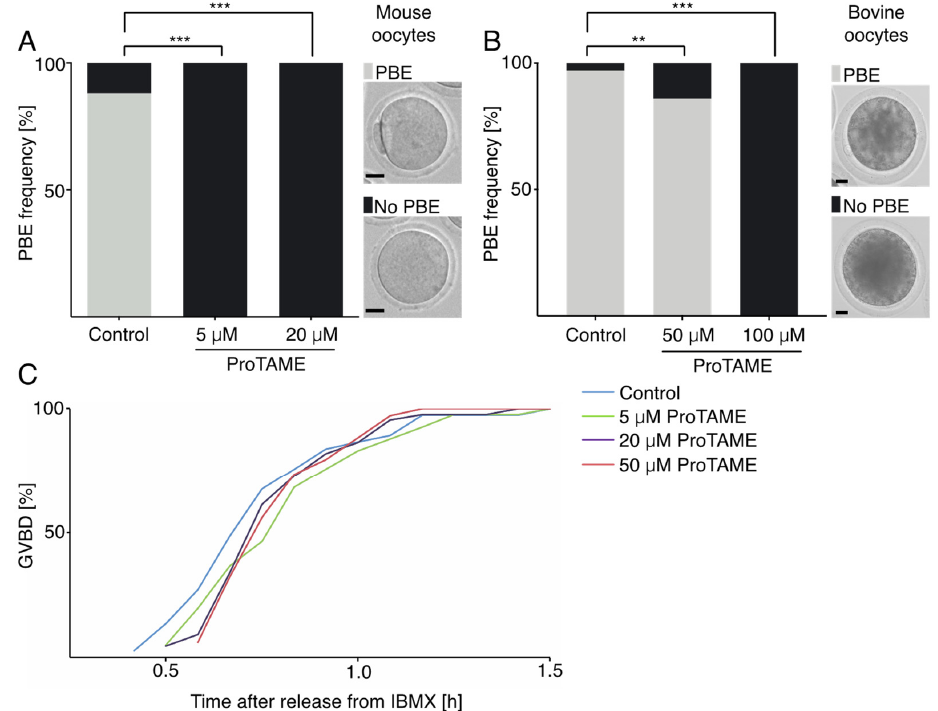
Figure 1. The impact of prodrug tosyl- l -arginine methyl ester (proTAME) on the meiotic maturation of mouse and bovine oocytes. ( A ) The frequency of polar body extrusion (PBE) in mouse untreated oocytes ( n = 43) and oocytes treated with 5 µ M ( n = 42) and 20 µ M ( n = 44) proTAME was scored. Oocyte maturation was monitored by live cell microscopy and 88% of cells in the control group and 0% in 5 µ M and 20 µ M proTAME underwent PBE. Data were obtained in two independent experiments. The right side panel shows representative examples of oocytes with and without PB. Scale bar: 20 µ m. The di ff erence between the control group and both 5 µ M and 20 µ M proTAME is statistically significant ( α < 0.05; *** p < 0.0001). ( B ) The frequency of PBE in bovine untreated oocytes ( n = 97) and oocytes treated with 50 µ M ( n = 92) and 100 µ M ( n = 83) proTAME was scored. PBE was scored after 20 h of maturation. A total of 97% of control cells, 86% of cells in 50 µ M and 0% of cells in 100 µ M proTAME underwent PBE. Data were obtained in two independent experiments. The right side panel shows representative examples of oocytes with and without PB. Scale bar: 20 µ m. The di ff erence between the control and 50 µ M proTAME is statistically significant ( α < 0.05; ** p = 0.0080); the di ff erence between the control and 100 µ M proTAME is also statistically significant ( α < 0.05; *** p < 0.0001). ( C ) Scoring of germinal vesicle breakdown (GVBD) in mouse untreated oocytes (light blue n = 37) and oocytes treated with 5 µ M (green, n = 41), 20 µ M (dark blue n = 44) and 50 µ M (brown, n = 34) proTAME. GVBD was monitored by live cell microscopy and data were obtained in two independent